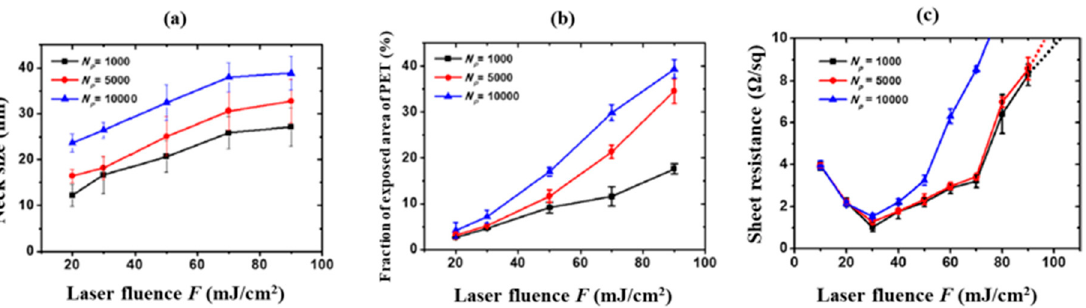
Figure 20. ( a ) Neck size; ( b ) fraction of the exposed area of the PET substrate after fs laser sintering; ( c ) sheet resistances of the fs laser sintered Ag particles [173].